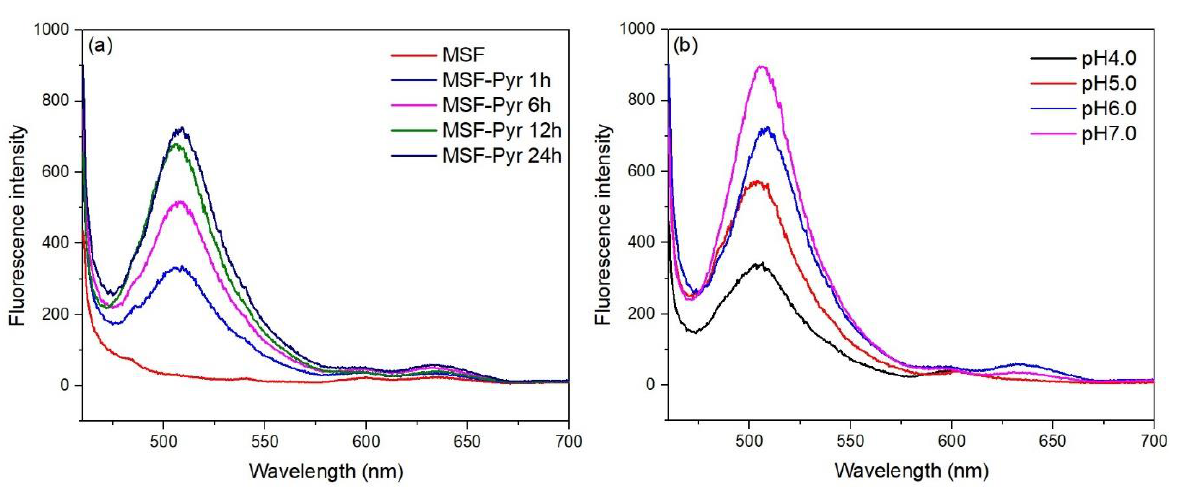
Figure 7. ( a ) Effect of time on dye immobilization at pH 6.0. (b ) Effect of pH of solution on film condition.